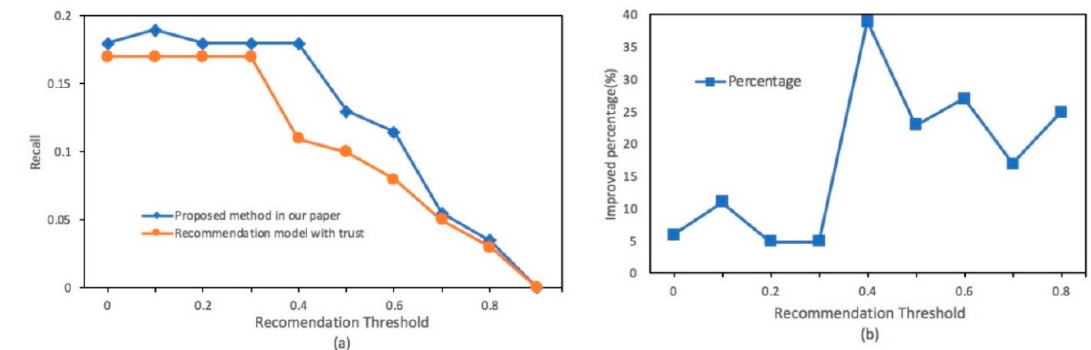
Figure 5. The result of the experiment in the health and personal care shop. ( a ) The results of recall under different recommendation thresholds; ( b ) the percentage of improvement of recall under different recommendation thresholds.